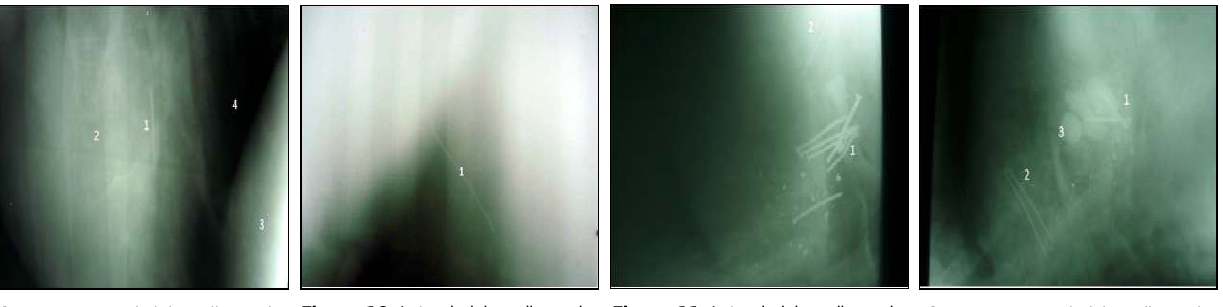
Figure-11. Lateral plain radiography of the cranial abdominal region in 5-year-old buffalo showing large number of radio-opaque metallic foreign bodies-nails (1) and hair- pin (2) within the reticulum.